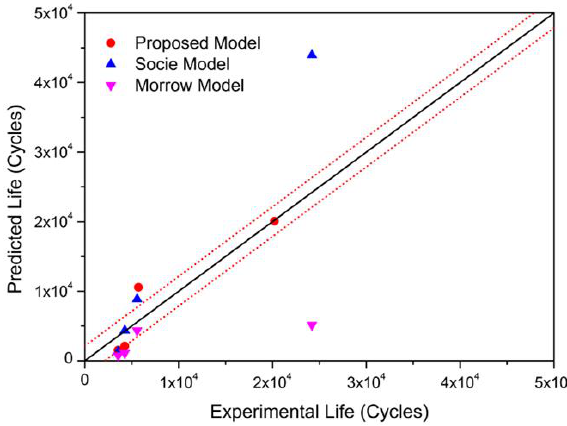
Figure 14. Comparison of predicted life and experimental life.